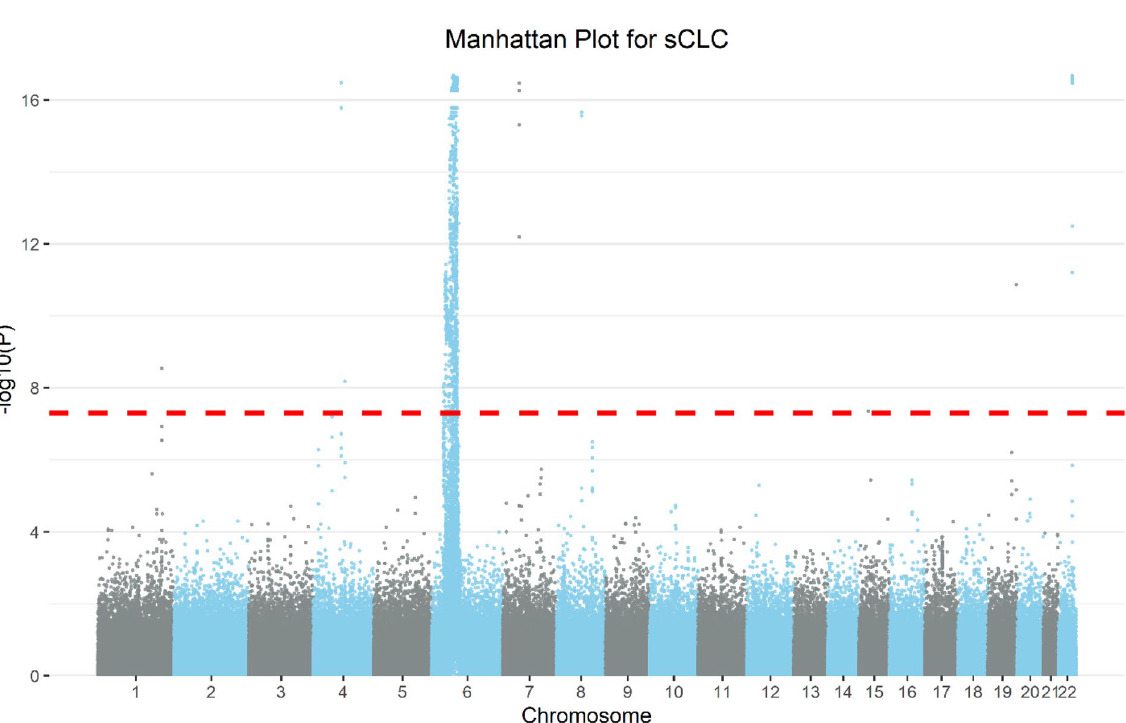
Figure 3. Manhattan Plot from the results of sCLC using multiple phenotypes based on the phenotypes on the UK Biobank XIII category. Each SNP ordered by the genomic position is represented in the x-axis and the association strength with the transformed p-values